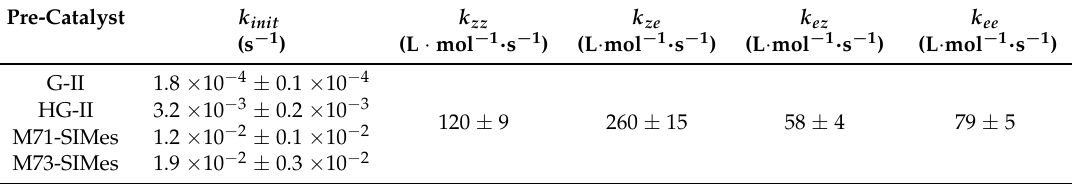
Table 1. Kinetic parameters obtained in the case of mesityl-substituted NHC ligands at 40 ◦ C.